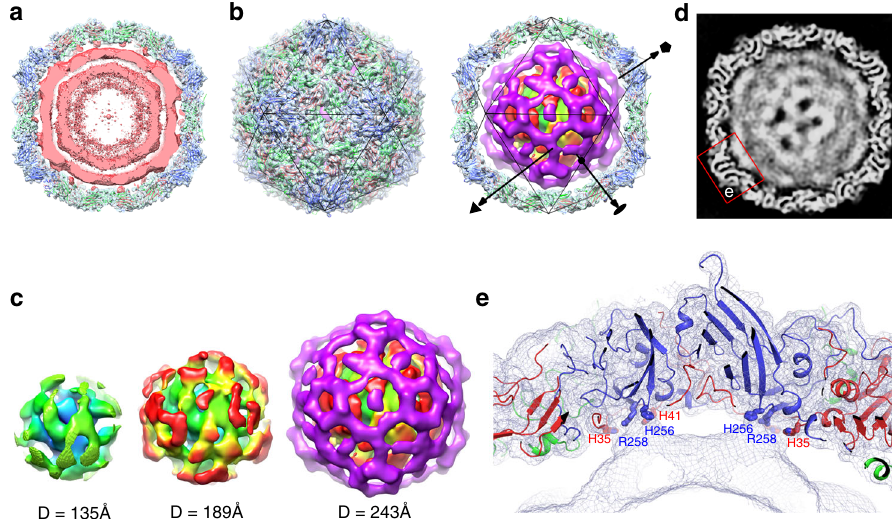
Fig. 4 Structure of CVA10 A-particle genome and its contacts with the capsid. a Central slab of the CVA10 A-particle density map of 22 Å thickness reconstructed by applying icosahedral symmetry and corresponding atomic model (ribbon diagrams) viewed down an icosahedral twofold axis. The densities for capsid shell and genome are colored in light blue and pink-red, respectively. Capsid – RNA interactions are observed beneath the VP1 and VP3 subunits. b The symmetry-mismatch reconstructed capsid structure of CVA10 A-particle (left) and a central slab of 22 Å thickness of the CVA10 A- particle capsid structure together with the structure of genomic RNA (right). The threefold axis, twofold axis, and fi vefold axis of symmetry are indicated by a triangle, an ellipse and a pentagon, respectively. c Structures of genomic RNA layers at different diameters viewed along the twofold axes, and are colored radially from blue, green through yellow, orange to magenta. d Central slice of the CVA10 A-particle structure showing the capsid and genomic RNA. Close-up of inset e is shown. e Slab of 22 Å thickness of CVA10 A-particle at the fi vefold axis with the external surface of the capsid facing upwards. VP1 (blue), VP2 (green), VP3 (red) are shown. Contacts between the genomic RNA and capsid are mediated by VP1 (H256, R258, labeled in blue) and VP3 (H35, H41, labeled in